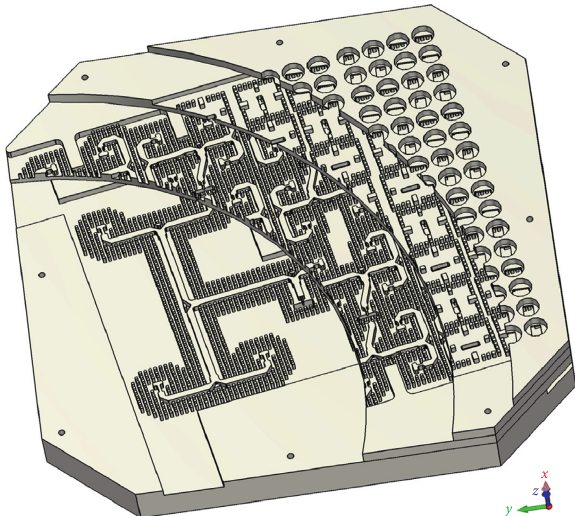
Figure 14: The perspective view of the simulated 16 × 16 CP array antenna.